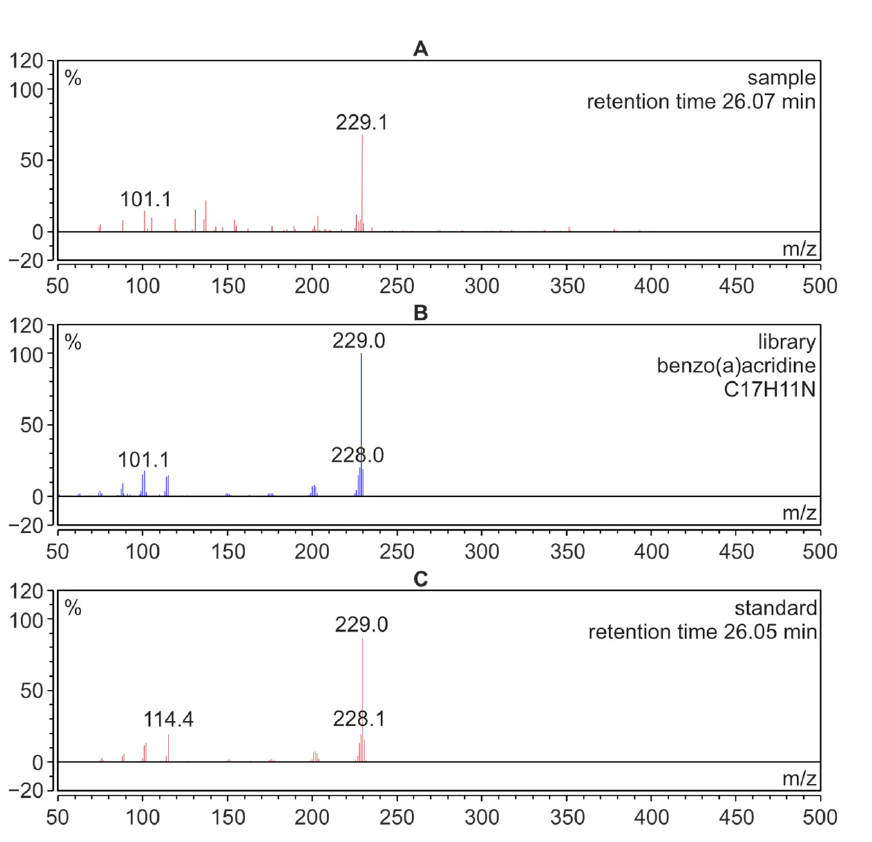
Figure 4. GC-MS mass spectra; ( A ): benzo[ a ]acridine identified in a sample of pork roasted without additives; ( B ): B a Acr from the Mainlib/NIST library resources; ( C ): spectrum of the B a Acr standard.